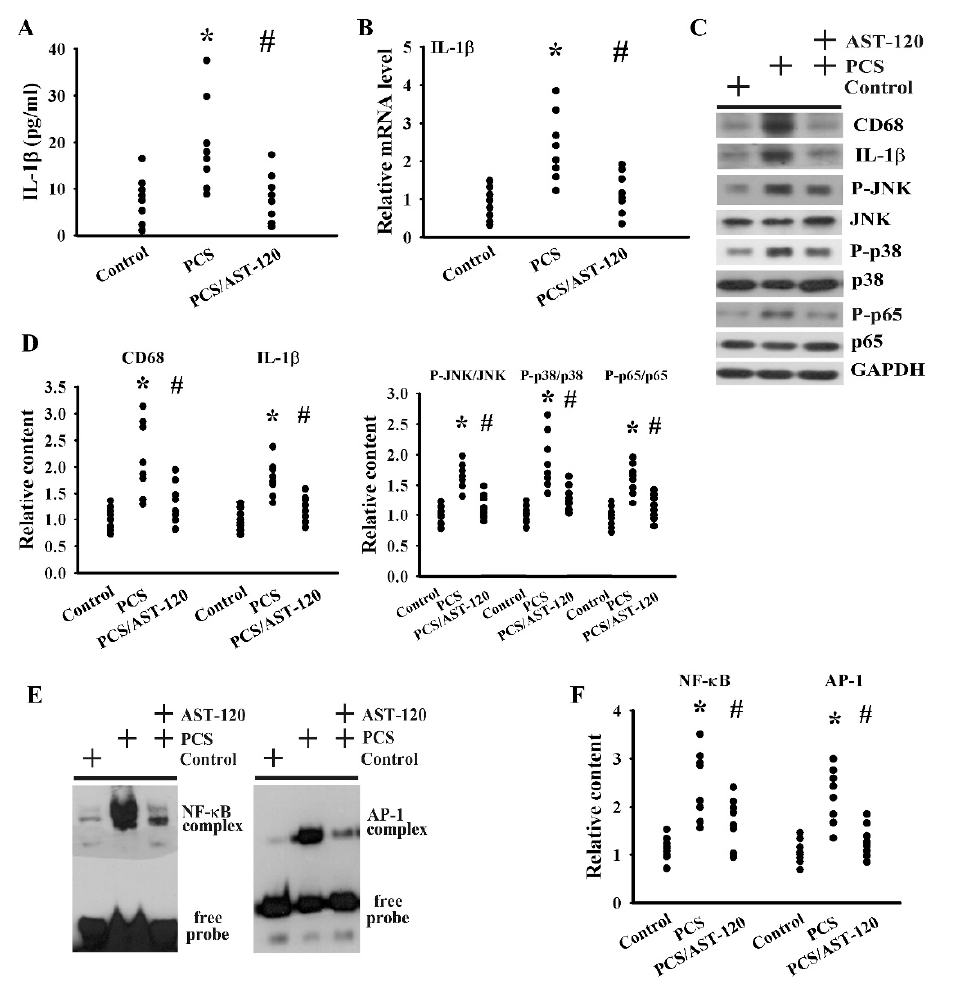
Figure 9. PCS induced neuroinflammation. Unilateral nephrectomized mice were intraperitoneally injected with PCS (0, Control; and 100 mg / kg, PCS) and the PCS-injected mice were orally given with AST-120 (400 mg / kg, PCS / AST-120) for 7 weeks. ( A ) The serum samples were collected and subjected to the measurement of IL-1 β levels. ( B ) Total RNAs were extracted from the isolated prefrontal cortical tissues and subjected to quantitative RT-PCR for the measurement of IL-1 β mRNA levels. Proteins were extracted from the isolated prefrontal cortical tissues and subjected to a Western blot test with the indicated antibodies. Representative blots ( C ) and the quantitative data ( D ) are shown. Nuclear proteins were extracted from the isolated prefrontal cortical tissues and subjected to EMSA for the measurement of NF- κ B and AP-1 DNA-binding activity. Representative blots ( E ) and the quantitative data ( F ) are shown. * p < 0.05 vs. control group and # p < 0.05 vs. PCS group, n =